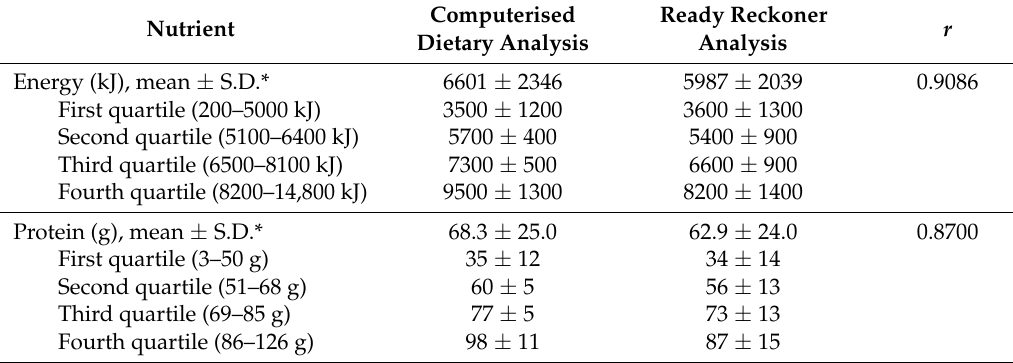
Table 2. Comparison of 24-h energy and protein intake calculated by computerised dietary analysis and ready reckoner 1 ( n =